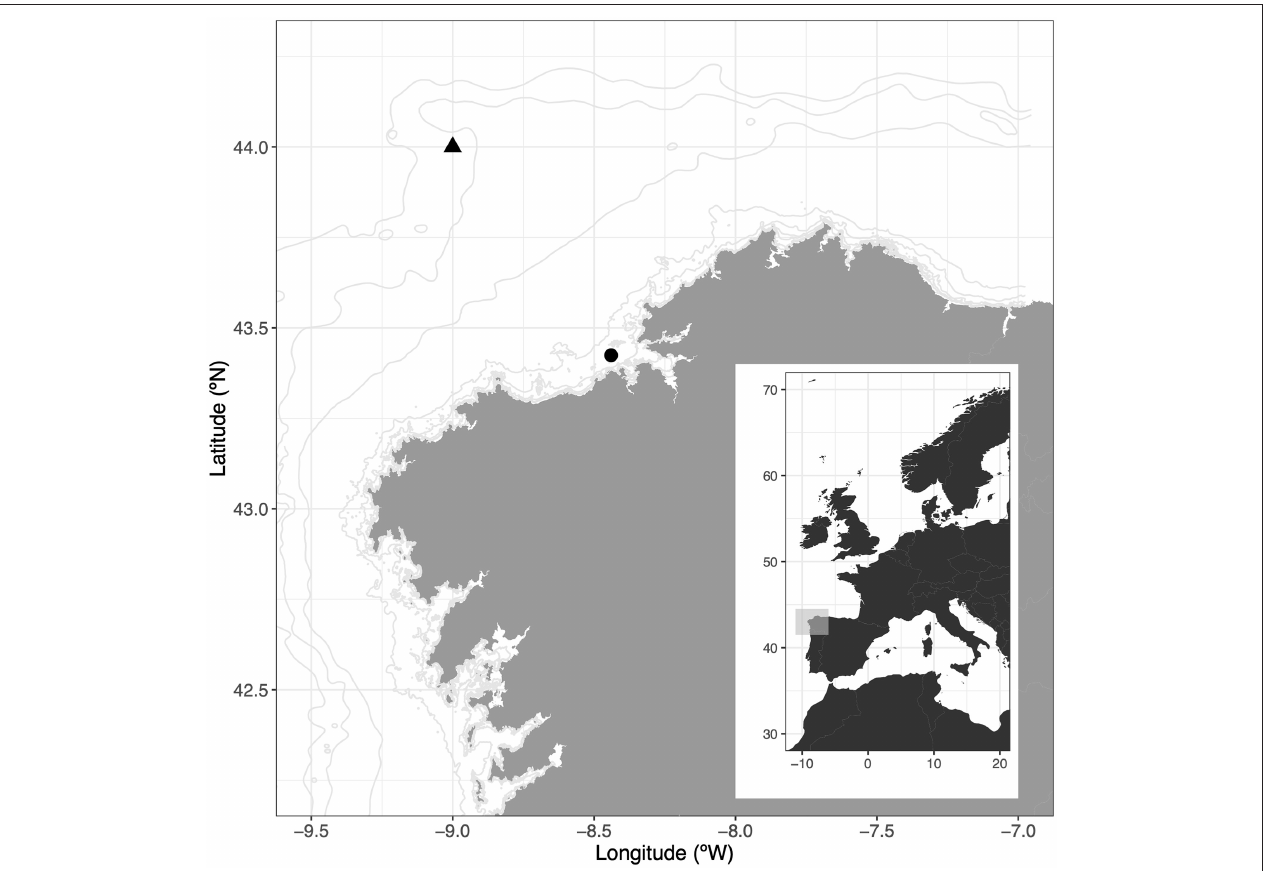
FIGURE 1 | Map of study area showing the location of the plankton and hydrographic sampling station (black dot), and the location of the grid cell where the upwelling index was calculated (black